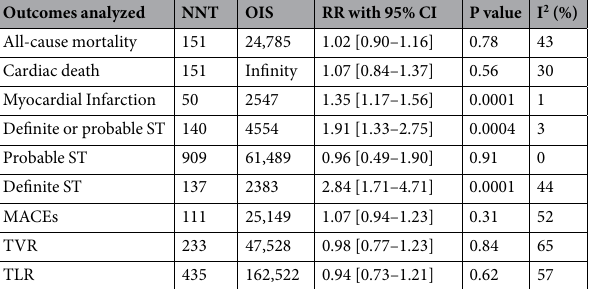
Outcomes analyzed